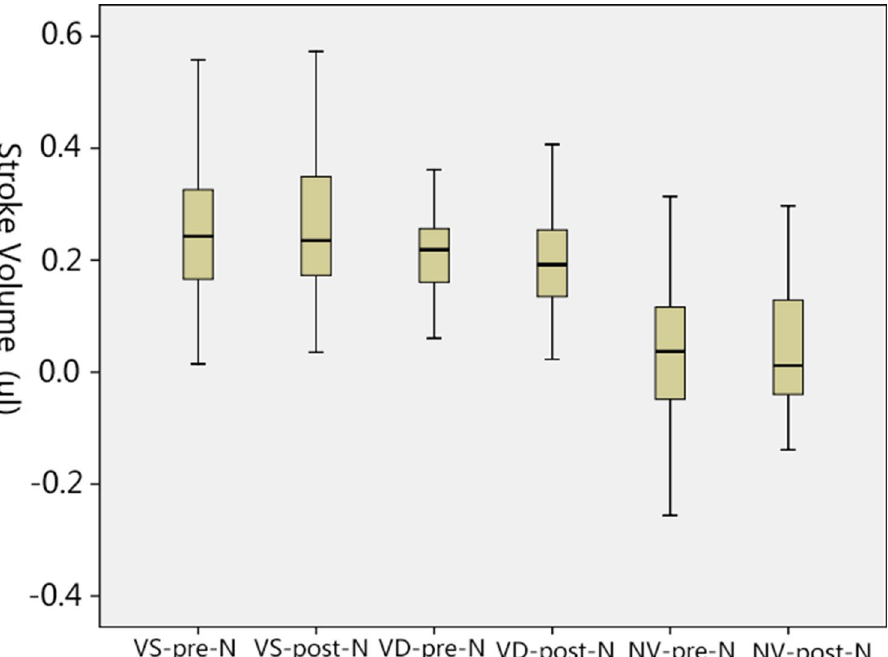
Figure 3. The CSF dynamics volumetric parameters were showed in Box and Whisker plots. It was impossible to re-measure the subjects with outliers, so these outliers were not included. VS-Pre-N (Pre-nodding VS) and